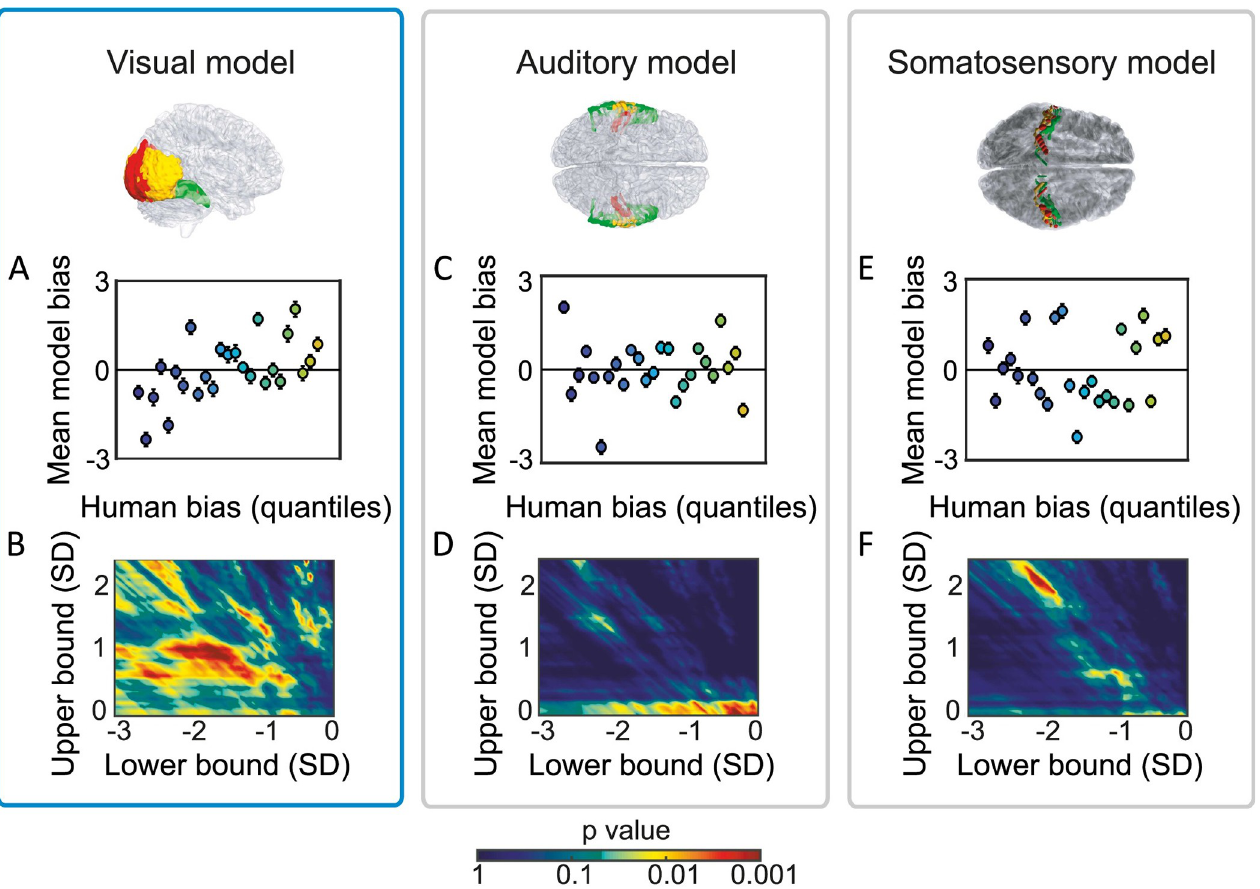
Fig 7. Predicting trial-by-trial subjective time from human BOLD. ( A) Mean normalized bias for the model trained on visual cortex activity, as a function of 25 quantiles of human bias. Colors represent x-axis values. Results show a positive association between human biases and model-predicted biases. (B) Heat map depicting p-values for the association between human bias and (visual cortex) model bias, as a function of minimum (x-axis) and maximum (y-axis) criterion values. Dark colors represent regions where the association was non-significant at α 0.05 or negative. Consistent results are found under a wide range of reasonable parameter values. (C,E). As for panel A, but for auditory and somatosensory cortex respectively. There is no association between human bias and model biases. (D,F). As for panel B, but for auditory and somatosensory cortex respectively. No significant positive correlation is found under alternative reasonable parameter